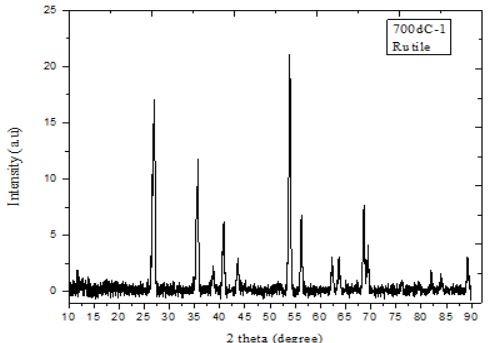
Figure 6. X-ray diffraction pattern of the obtained rutile-TiO 2 NPs. The average crystallite size of the obtained rutile-TiO 2 nanoparticles was calculated to be 19.7 nm. The size was determined by the use of the Scherrer equation (Equation 1) [56] as given in Equation (1).